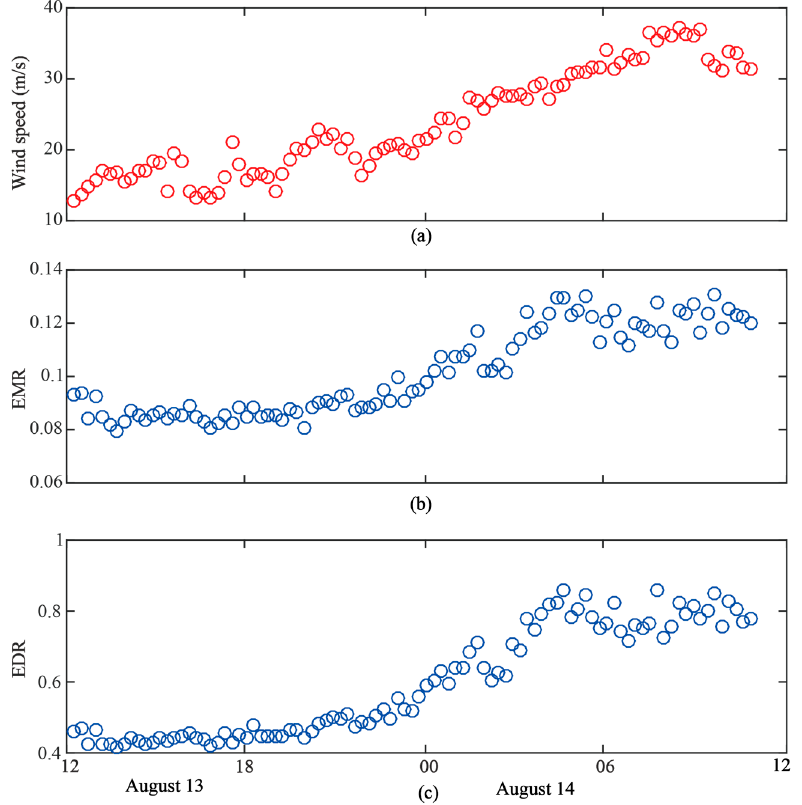
Figure 8. Comparison between in situ wind speed measurement and observables during the Typhoon UTOR. ( a ) In situ wind speed. ( b ) EMR. ( c ) EDR. EMR and EDR are computed with Threshold 2 = 0.25.